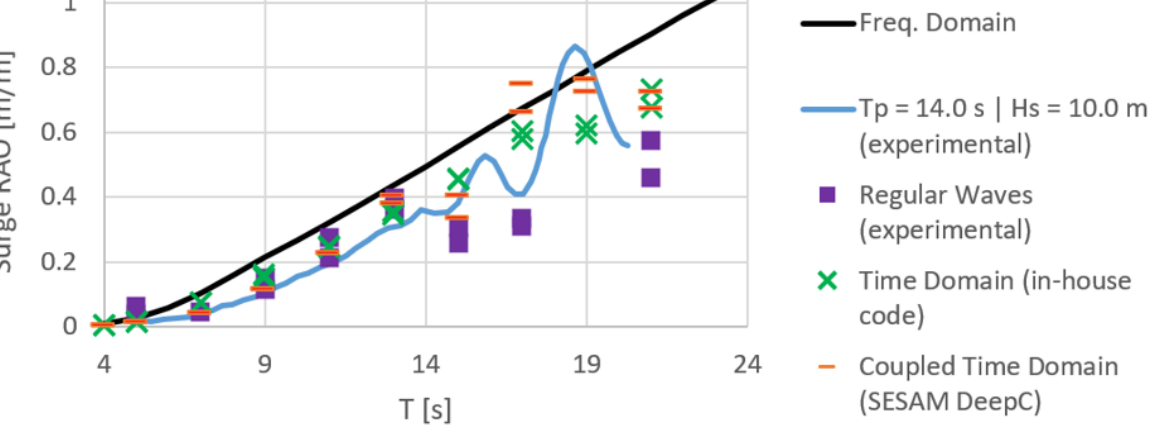
Figure 6. Surge RAOs according to different methods.